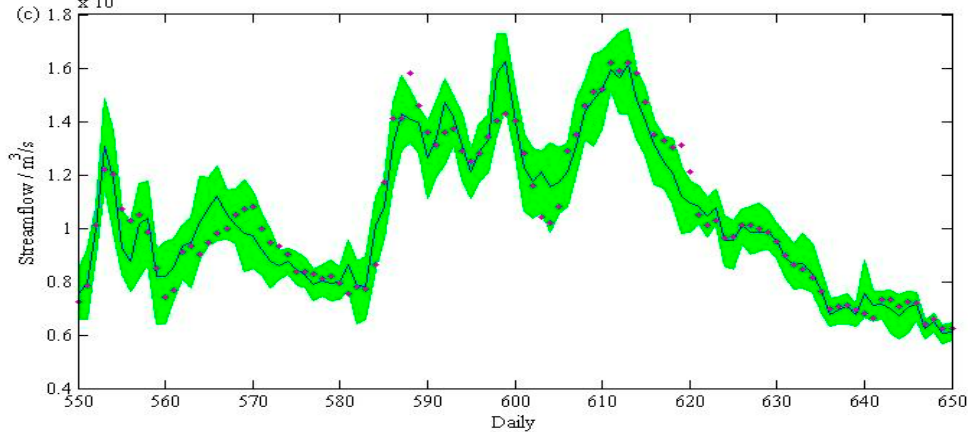
Figure 10. Daily ensemble prediction band of runoff, ensemble mean, observed values and VIC model ‐ simulated values (whole basin).